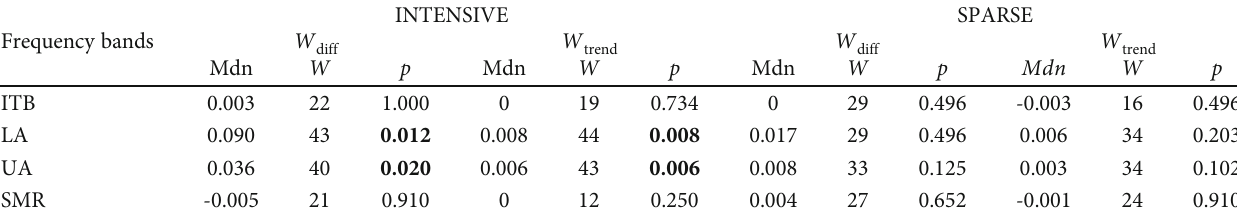
Table 3: Within-group analysis within session.